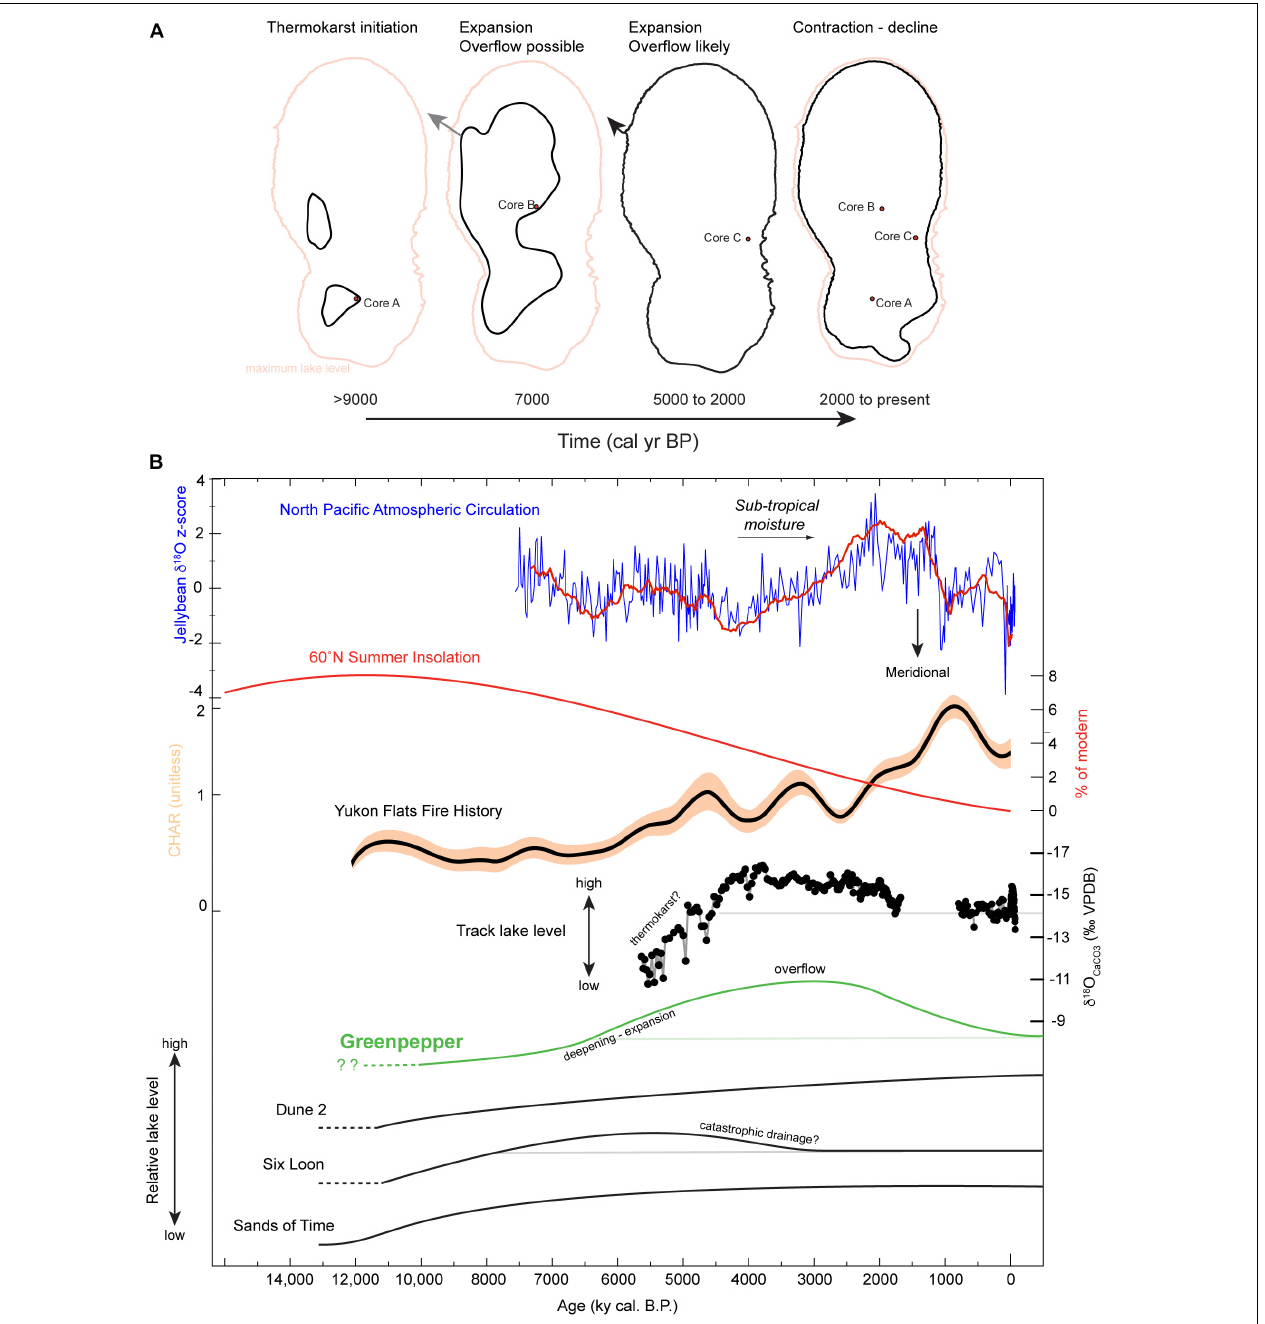
FIGURE 10 | (A) Schematic of Greenpepper Lake shoreline evolution from ∼ 9000 cal yr BP to present. Faint orange outline of outlet elevation shoreline at 211.5 m is shown on each panel for context. (B) The evolution of loess plateau lakes on a relative lake level scale including Greenpepper (this study), and SoT, 6L, and D2 Lakes adapted from Edwards et al. (2016). Dashed lines represent periods of ‘trash’ layer development indicating thermokarst initiation and solid lines indicate periods of lacustrine sedimentation. The loess plateau lake levels are shown with the Jellybean Lake oxygen isotope record of North Pacific atmospheric circulation ( z -score; Anderson et al., 2016), 60 ◦ N summer solar insolation (percent of modern), Yukon Flats fire history (normalized scale, Kelly et al., 2013), and Track Lake levels based on carbonate oxygen isotopes (Anderson et al., 2018).